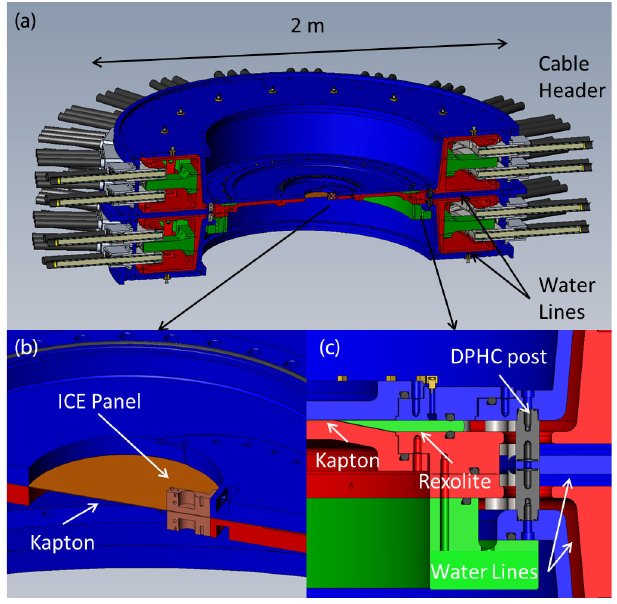
FIG. 4. (a) Cutaway view of the CPF. (b) View of ICE panel in the center load region. (c) Cable header and DI water line section.